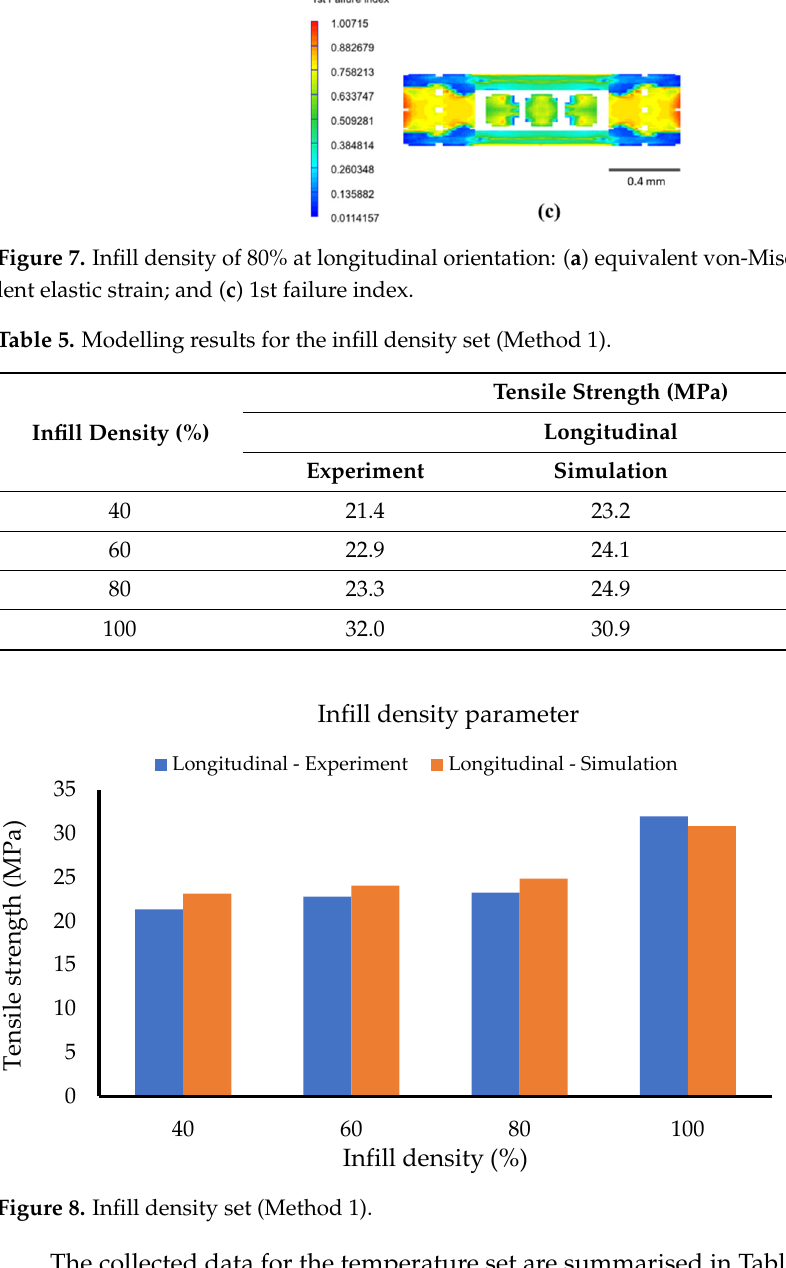
Table 6. Modelling results for the layer thickness set (Method 1).